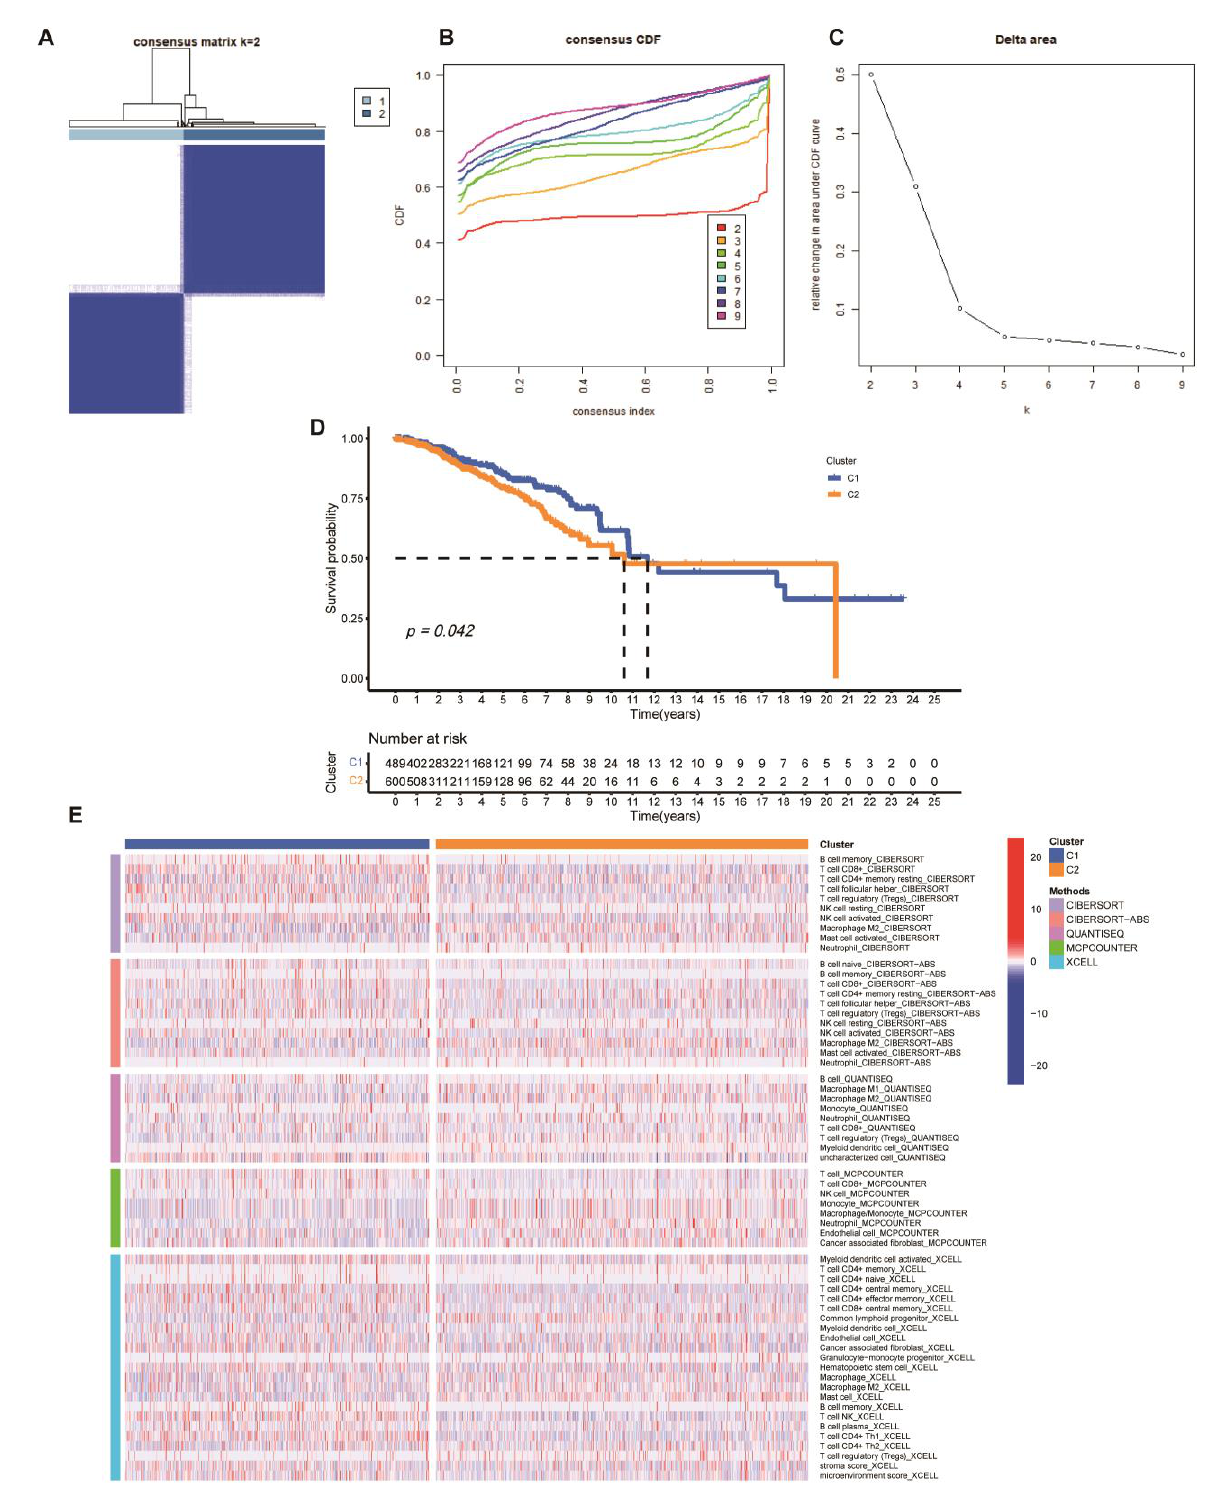
Figure 8. Clustering analysis of ribosome-related genes in TCGA cohort. ( A – C ) Identification of ribosome related cluster in the TCGA cohort by NMF method; consensus clustering results K = 2 to 9 were shown, K = 2 was the optimal choice. ( D ) Kaplan – Meier curve survival analysis in different ribosome related clusters. ( E ) Immune cell infiltration in different ribosome-associated clusters.